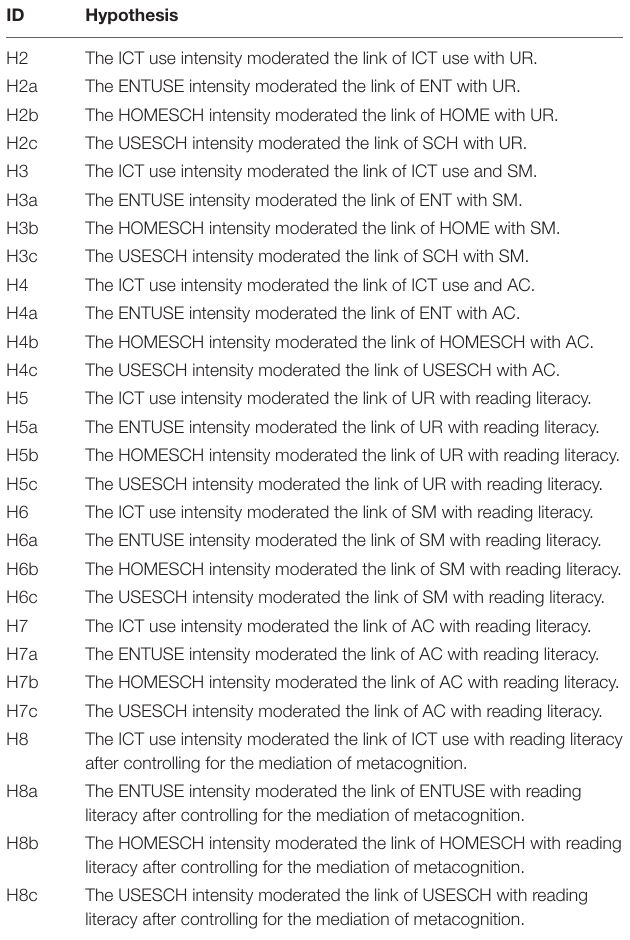
TABLE 2 | The specific hypotheses of moderated-mediation analysis.